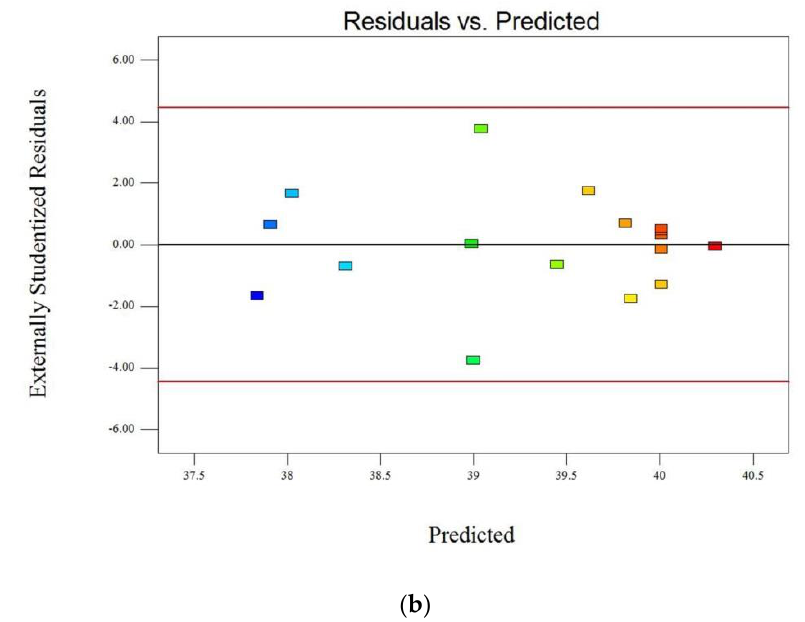
Figure 4. ( a ) Normal probability plots of the residuals and; ( b ) plot of the residuals versus the predicted response.